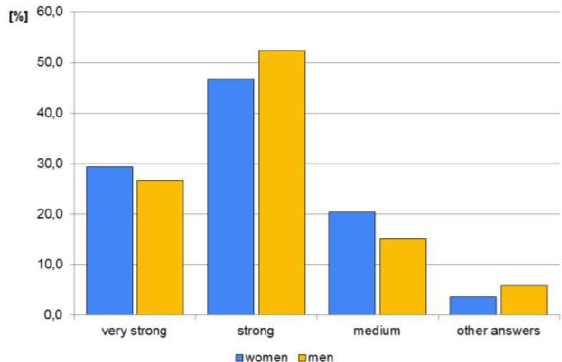
Fig. 3. Degree to which a relationship was felt with the place of work (distribution of answers to the question about the degree to which a relationship was felt with the place in which the respondent works)